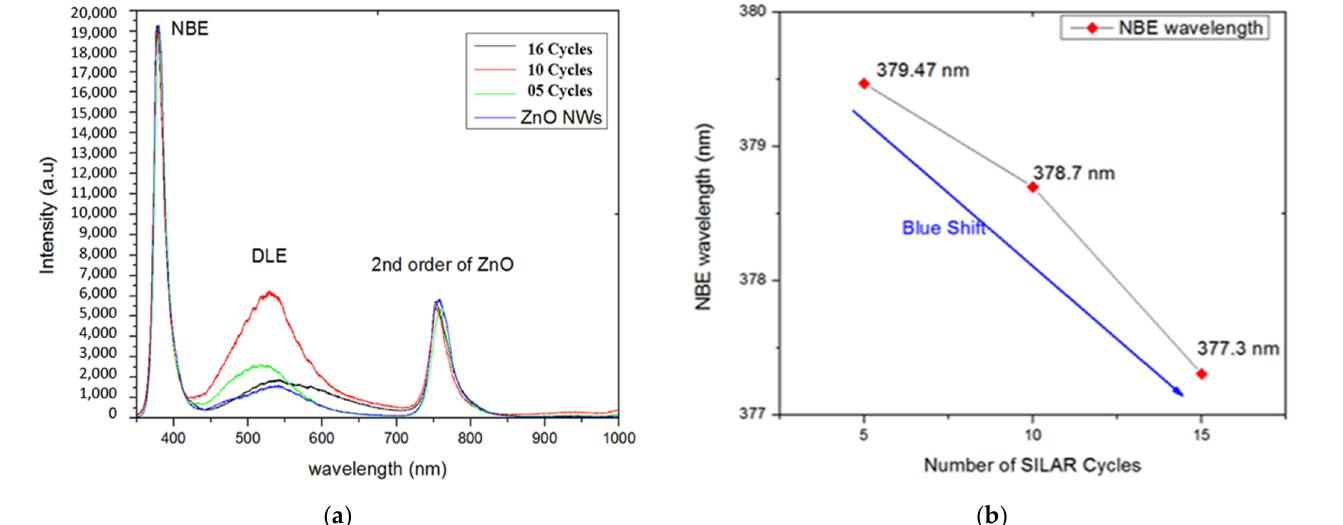
Figure 7. ( a ) PL spectra of the ZnO NWs decorated with PbS NPs synthesized at different SILAR cycles and ( b ) NBE wavelength of the ZnO NWs decorated with PbS NPs in relation to the number of cycles. Figure 8 shows the X-ray fluorescence (XRF) data on the relative intensity of lead (Pb), sulfur (S) and zinc (Zn) for three different numbers of cycles. The difference in intensity is due to the different concentration of PbS grown directly on the ZnO NWs. A higher intensity is identified in sample C, which corresponds with the higher number of cycles (16 SILAR cycles).